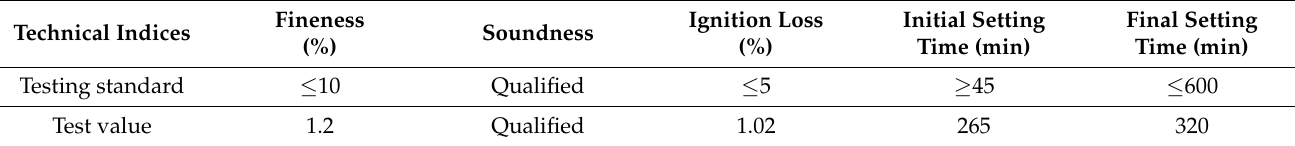
Table 3. Technical properties of cement.